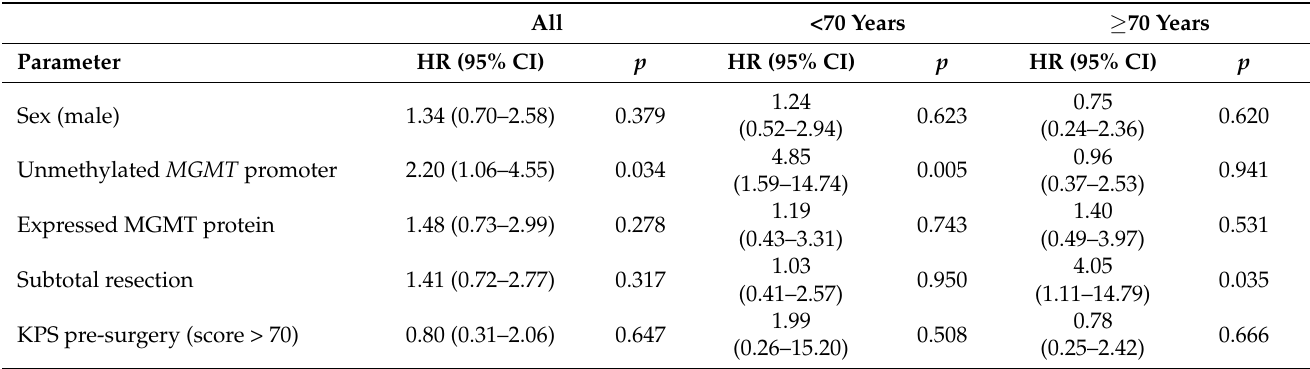
Table 3. Univariate Cox proportional hazard model of OS in patients with glioblastoma WHO grade IV. The data are shown for all patients (All), patients younger than 70 years of age (<70 years) and patients with an age of 70 years or more ( ≥ 70 years). References in the model were female sex, methylated MGMT promoter, low MGMT protein expression, gross total resection and a Karnofsky performance score below 70. The hazard ratio (HR), the 95% confidence interval (CI) and the corresponding p -value are